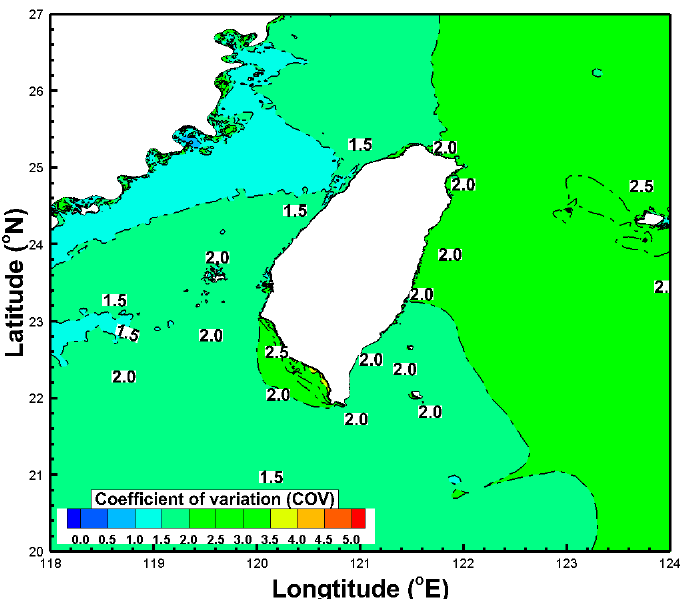
Figure 14. Spatial distribution of the coefficient of variation (COV) of wave power in the offshore waters of Taiwan averaged over 1991 to 2010.